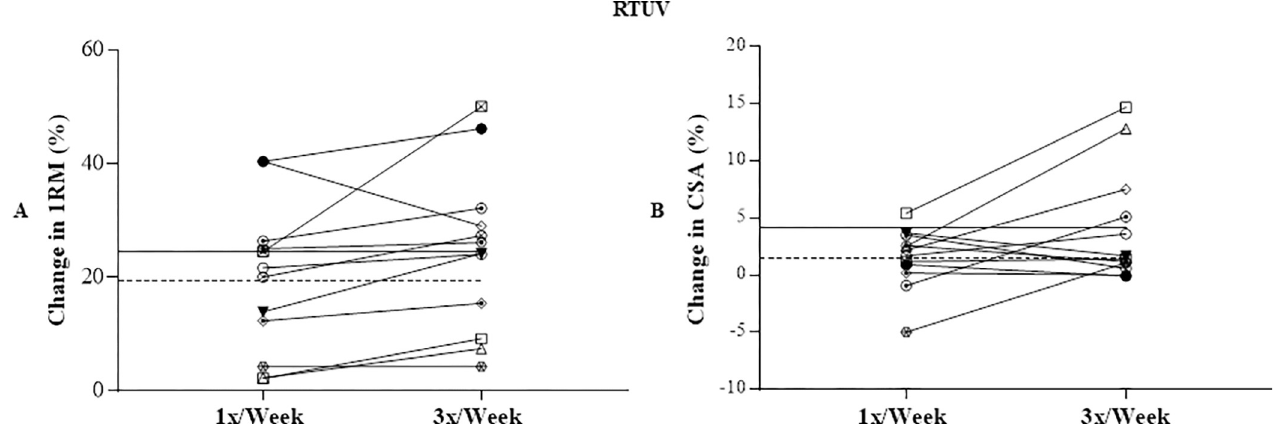
Fig 5. Individual percentage change in the values of 1RM (A) and CSA (B) in the RTUV. 1RM, maximum dynamic strength; CSA, quadriceps femoris cross- sectional area; RTUV, resistance training with unequalized total training volume; ———, average of the percentage change 1x/week;–––––, average of the percentage change